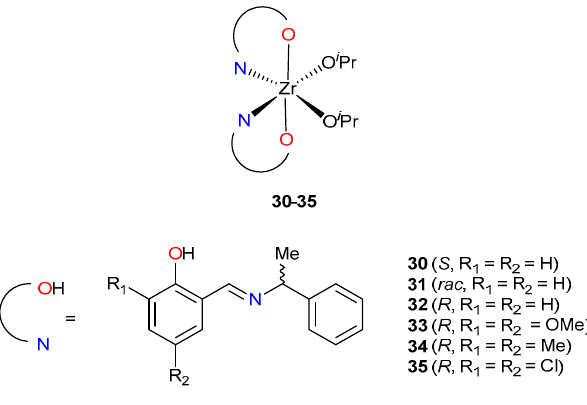
Figure 6. Chiral Zr complexes 30–35 [39].